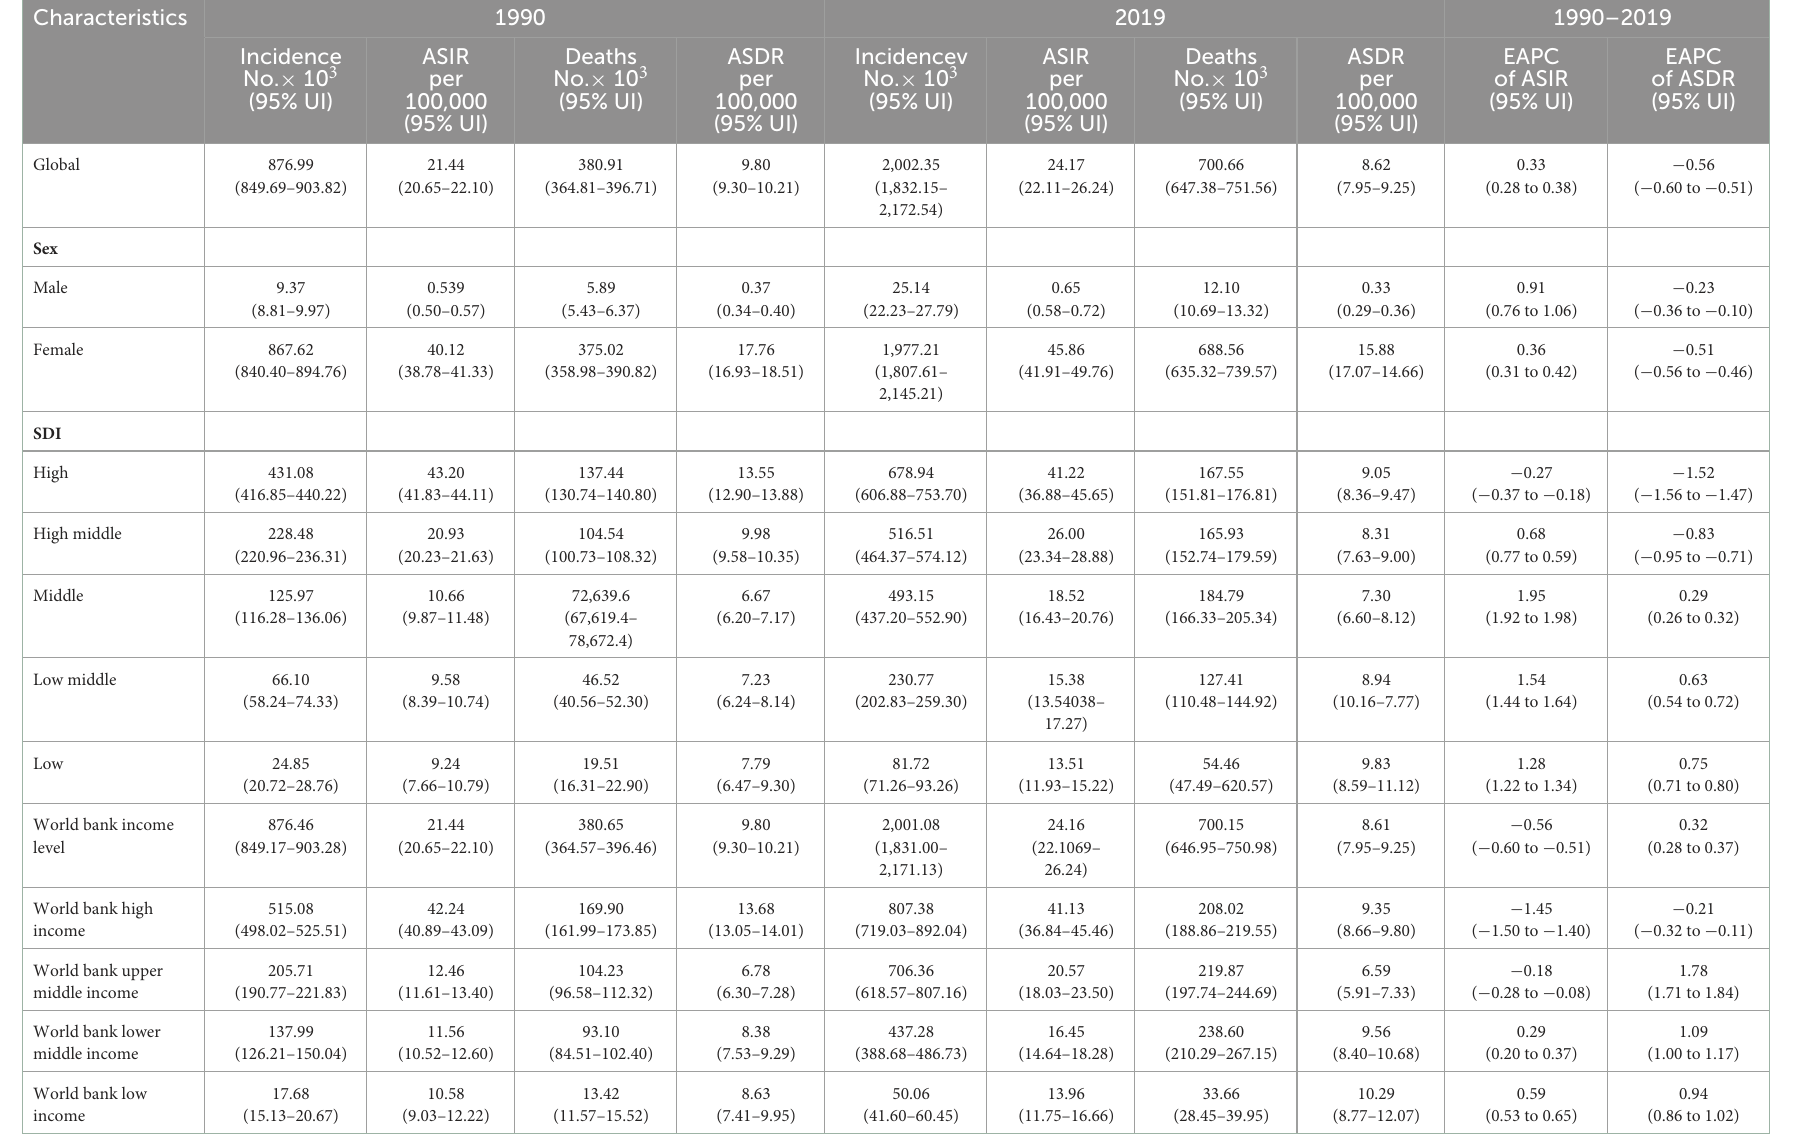
TABLE 1 The incidence and death cases and their age-standardized rates of breast cancer in 1990 and 2019, and its temporal trends from 1990 to 2019.